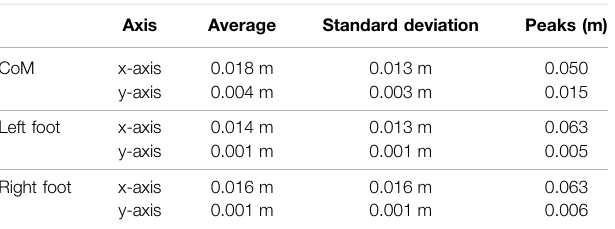
TABLE 3 | CoM and feet error of the 60-cm step walk.